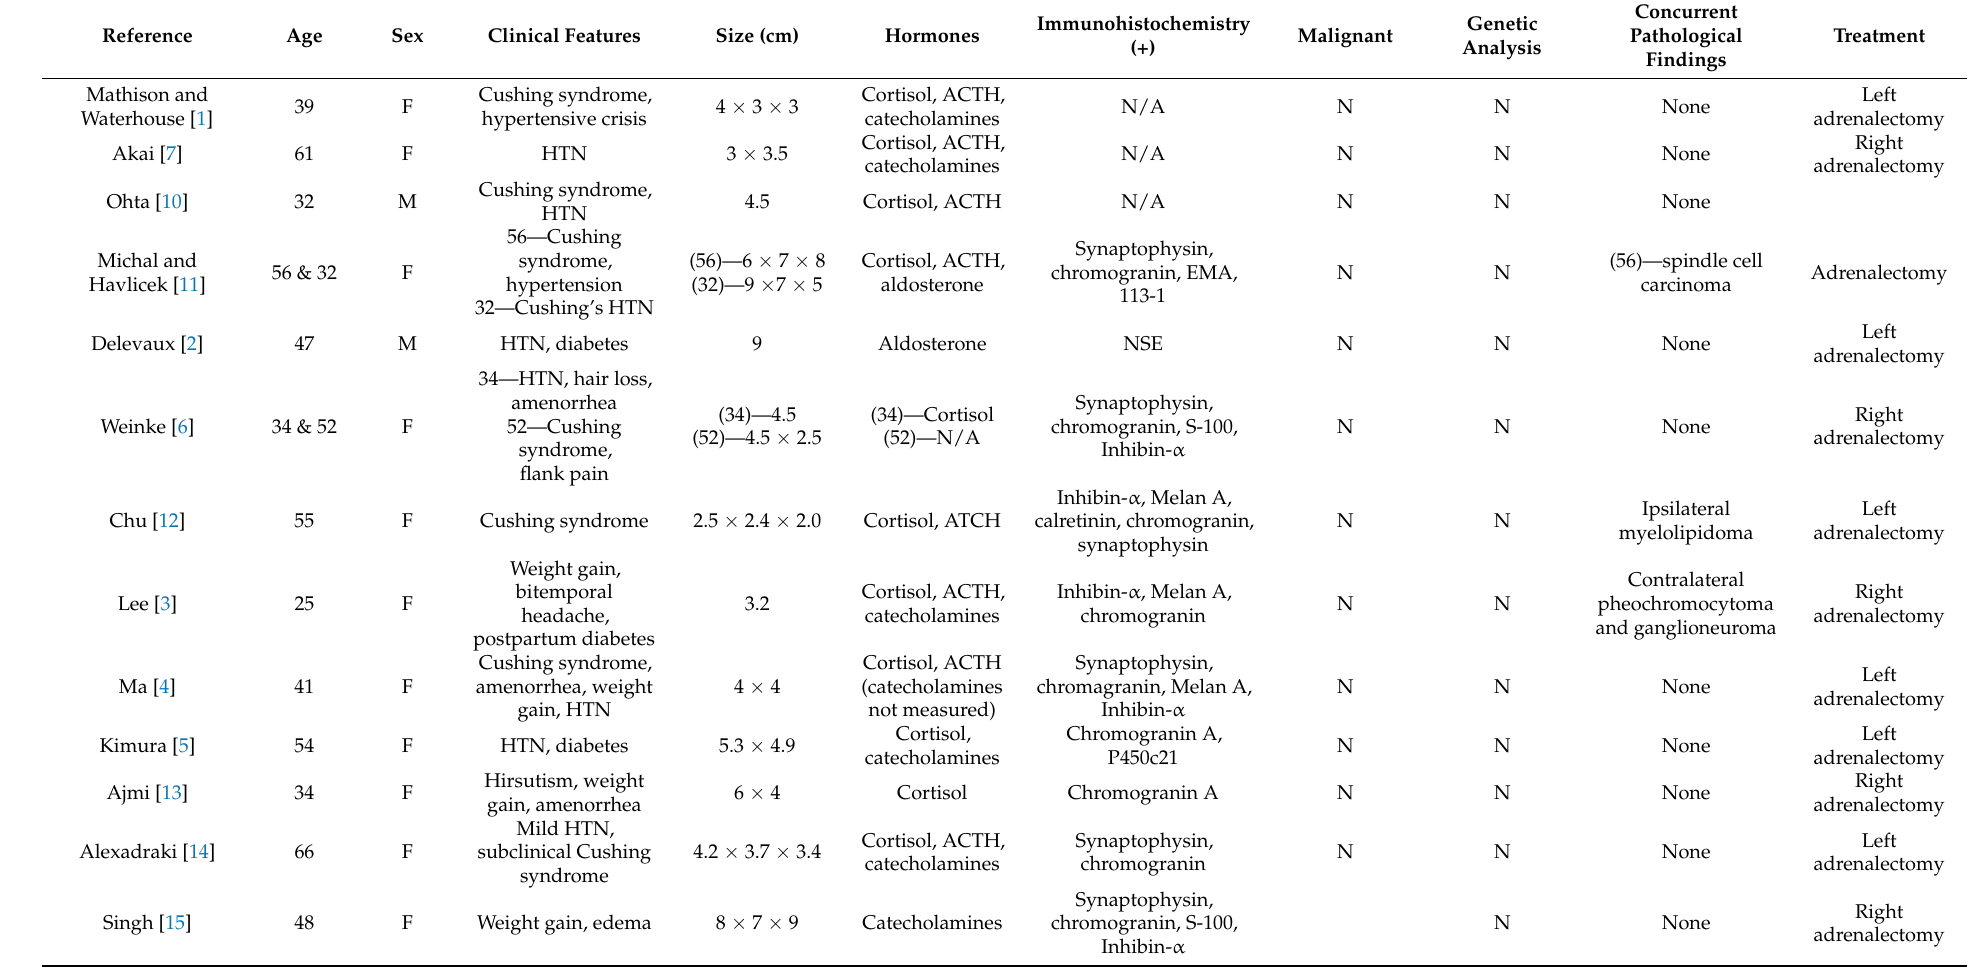
Table 2. Documented cases of mixed corticomedullary tumors (benign and malignant). TH (tyrosine hydroxylase); DBH (dopamine beta hydroxylase);